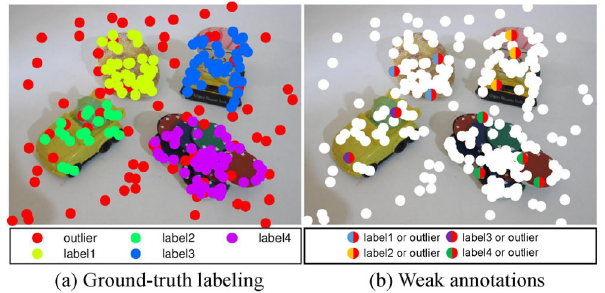
Fig. 1 Weak annotations in the two-view motion segmentation task (only one view is shown here). (a) Ground-truth labeling. Four objects are with independent motions; camera movement induces outliers. (b) Detected feature points (dots) include weakly annotated ones (red) and unlabeled ones (white). The annotator annotates points on an object with a corresponding bi-colored weak label, as they can not distinguish them from outliers. Note that the number of weak labels in (b) is not necessarily equal to the number of ground-truth labels in